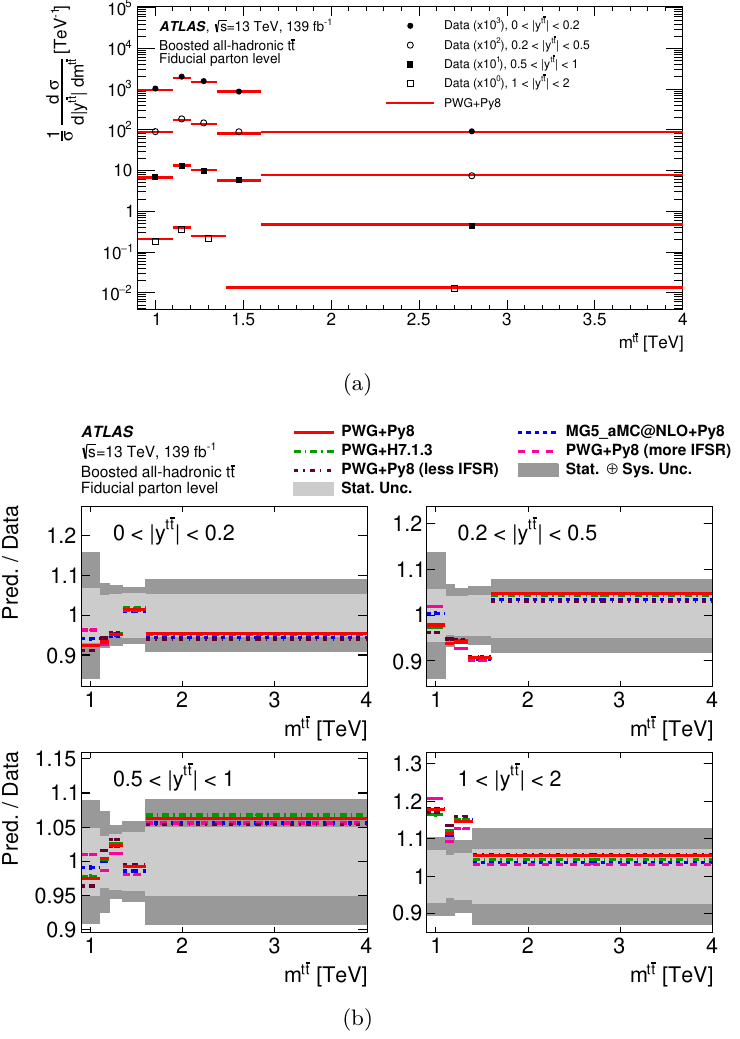
Figure 50 . (a) Normalized parton-level fiducial phase-space double-differential cross-sections as a function of the absolute value of the rapidity and the mass of the t ¯ t system, compared with the Powheg+Pythia 8 calculation. Data points are placed at the centre of each bin and the Powheg+Pythia 8 calculation is indicated by solid lines. The measurement and the prediction are normalized by the factors shown in parentheses to aid visibility. (b) The ratios of various MC calculations to the normalized parton-level fiducial phase-space differential cross-sections. The dark and light grey bands indicate the total uncertainty and the statistical uncertainty, respectively, of the data in each